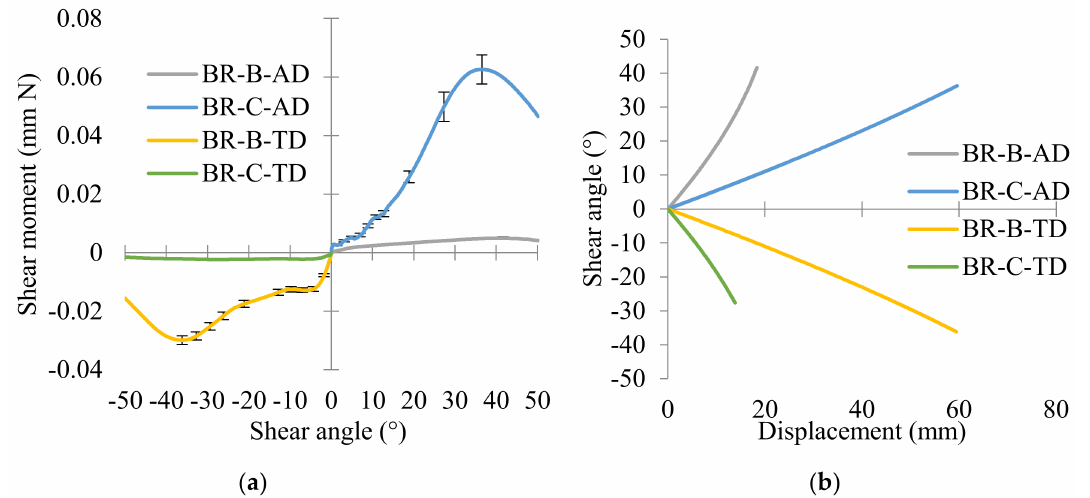
Figure 12. Influence of braiding angle on thermal in-plane shear behavior: ( a ) shear moment versus shear angle curves and ( b ) shear angle versus displacement